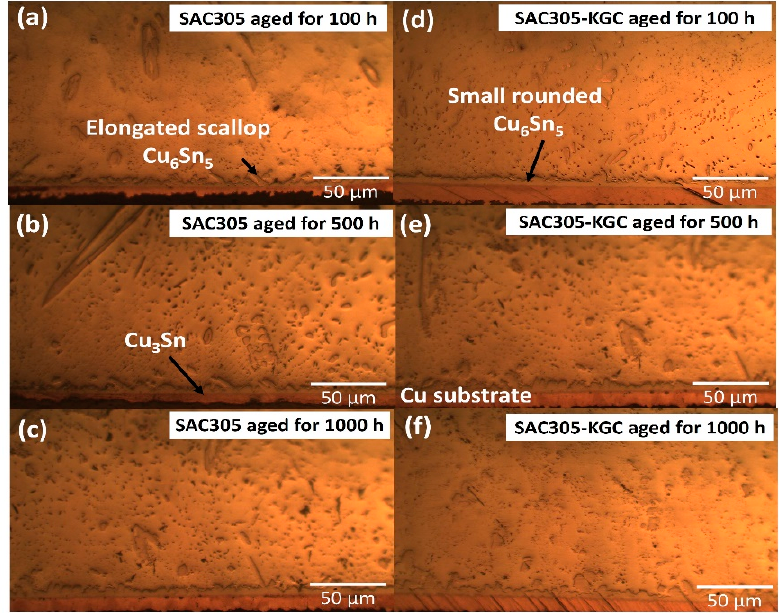
Figure 8. Interfacial IMC layer subjected to isothermal ageing at 125 °C. Non-reinforced SAC305 at